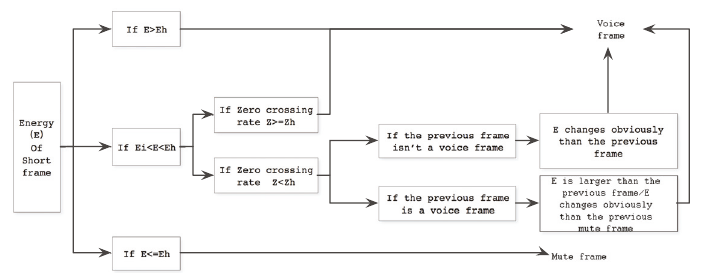
Figure 8: Voice activity detection